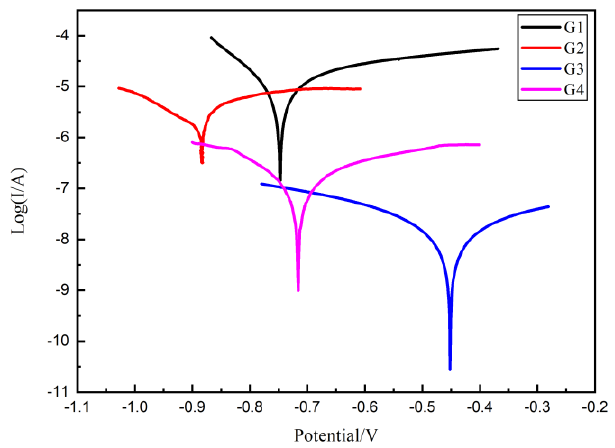
Figure 11. Each EP/CeO 2 -GO coating’s Tafel curve for 160 d.